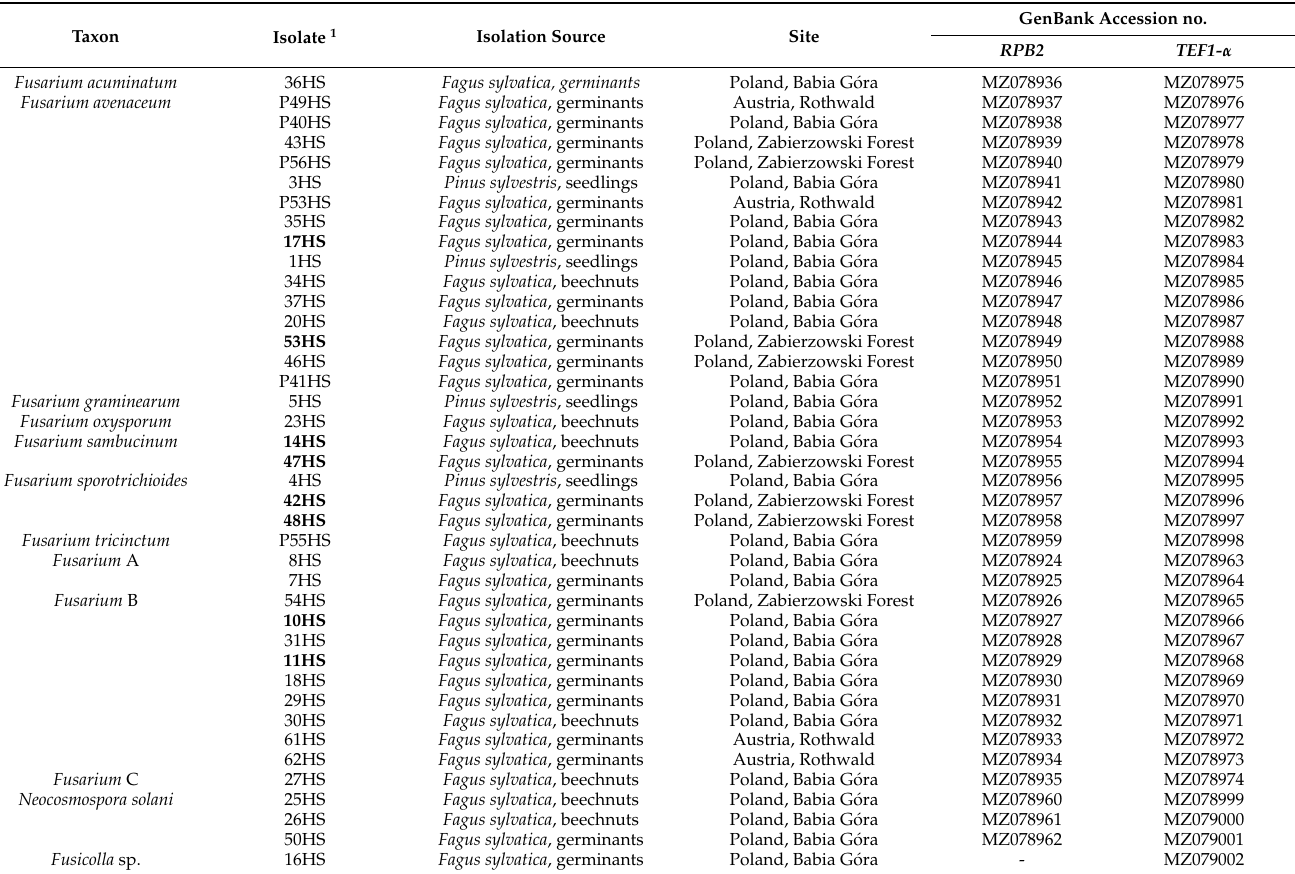
Table 1. Cultures used in this study and GenBank accession numbers for